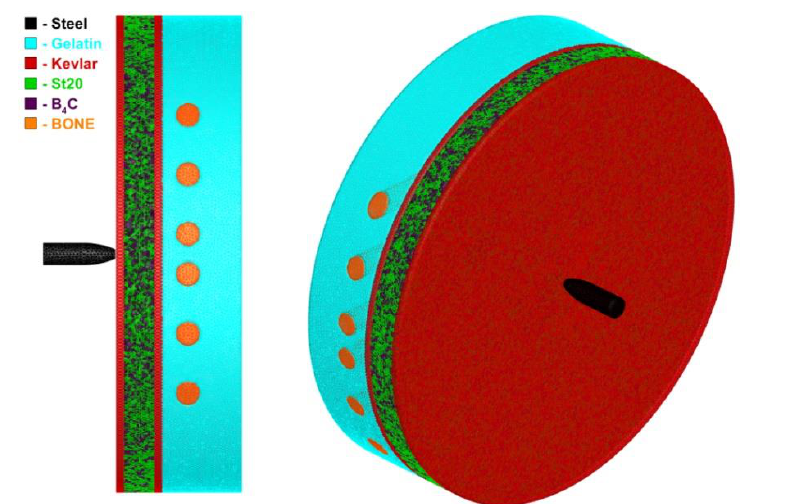
Fig. 7. Three-dimensional protective plate made of a gradient material obtained by randomly distributing the concentration of ceramics in steel (model 3).